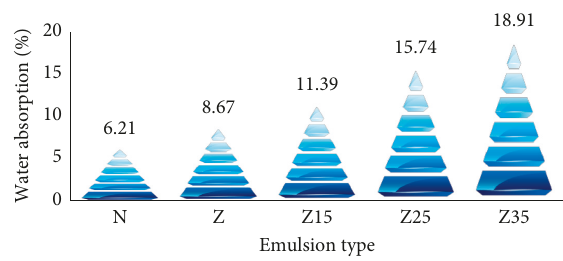
Figure 3: Water absorption of